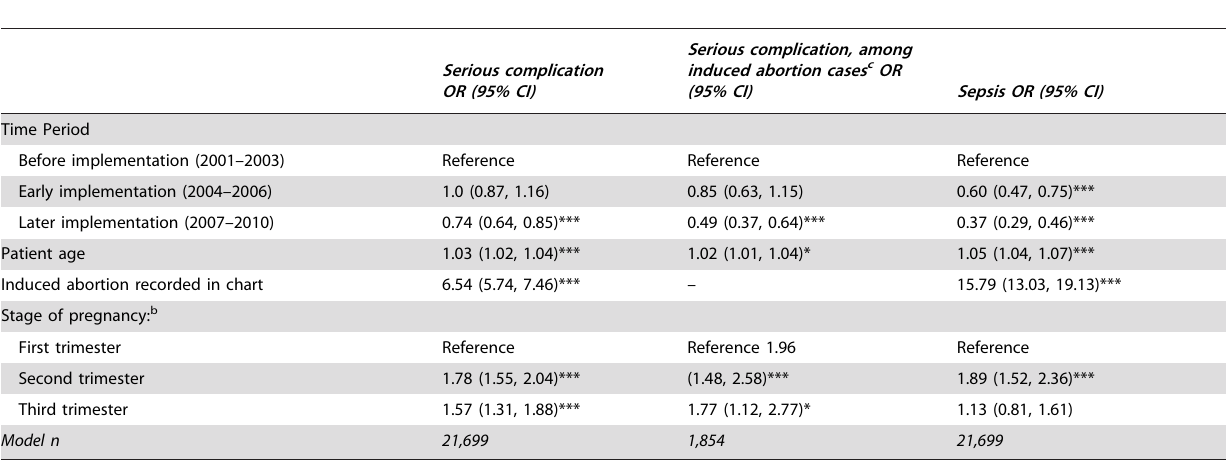
Table 3. Multiple variable analysis of factors associated with serious abortion complications, adjusted logistic regression odds ratios a